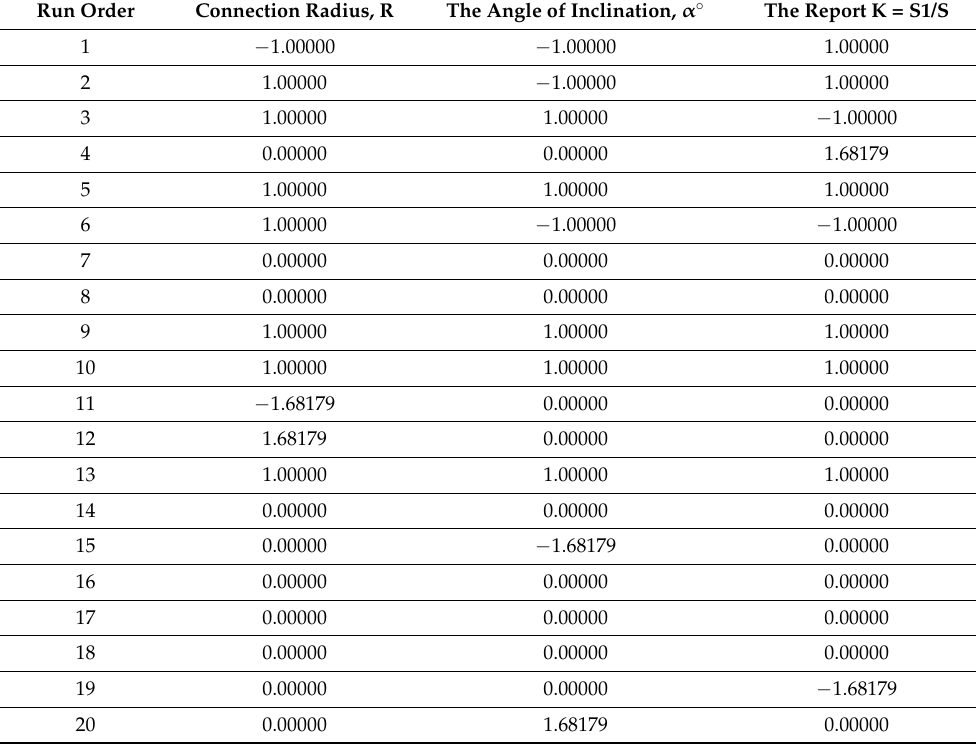
Table 3. Sequence of experiments obtained using